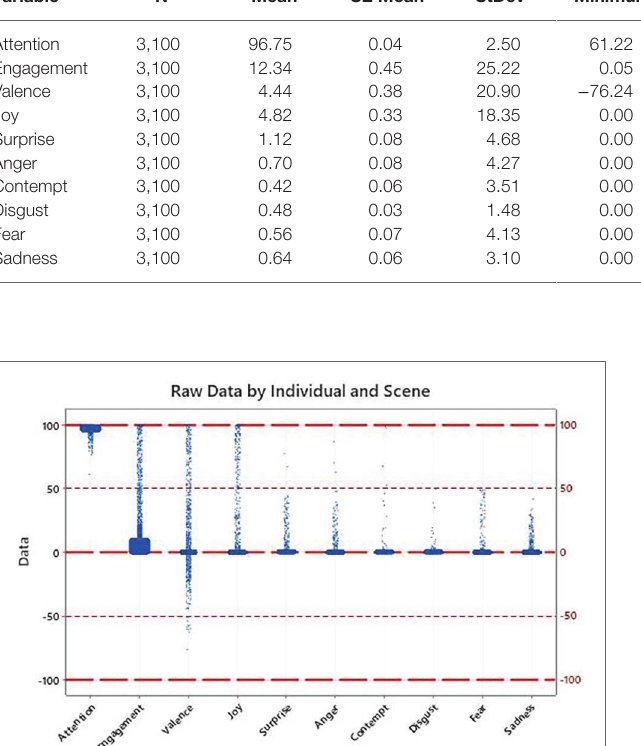
TABLE 2 | Descriptive statistics for the whole sample by emotional response. Variable